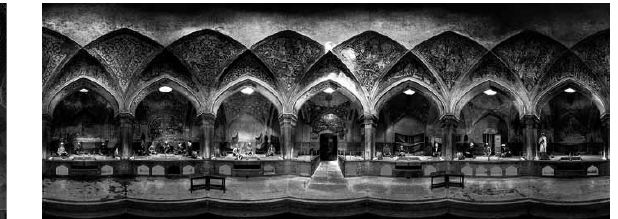
fig. 14. Panoramic view of Vakil Bath Hot Chamber surrounding by small rooms for social encounters ( photo by Mohammad reza Domiri